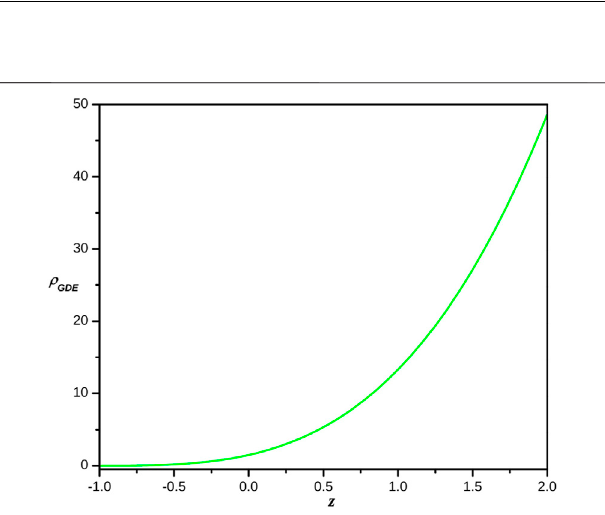
FIGURE 1 | Plot of reconstructed ghost dark energy f ( Q ) gravity model versus redshift for the appropriate choice of constants c = 0.1 and c 1 = 3.0.